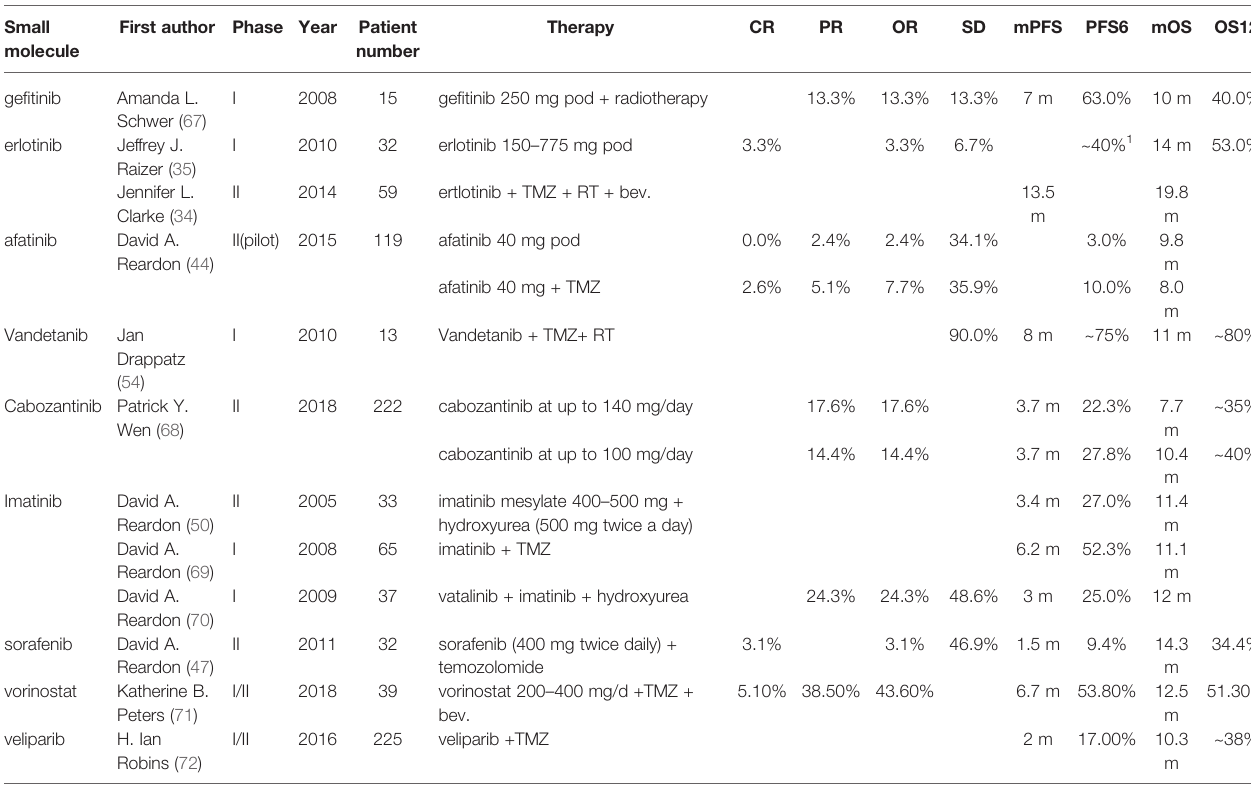
TABLE 1 | Part of clinical studies which claimed “ non-inferiority ” for historical results. Small